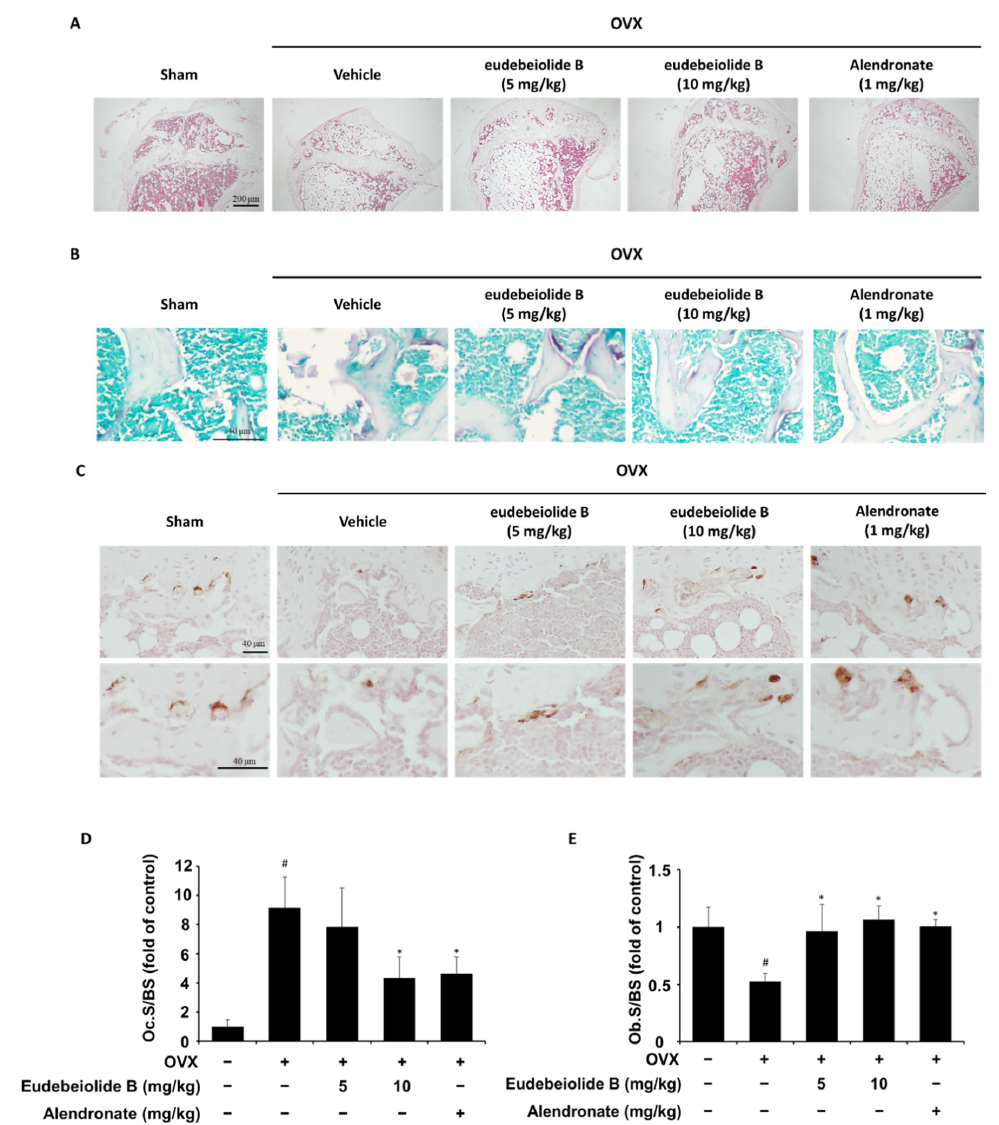
Figure 7. Histological analysis of the proximal tibia tissue sections from the eudebeiolide B- or alendronate-treated OVX mice. ( A ) H&E stains, ( B ) histochemical stains for TRAP and ( C ) immunohistochemical stains for ALP of the sham-operated, OVX + vehicle, OVX + eudebeiolide B-treated and OVX + alendronate-treated mice were obtained ( n = 6). ( D ) Osteoclast surface/bone surface (Oc.S/BS) and ( E ) Osteoblast surface/bone surface (Ob.S/BS) were evaluated by HistoMorph software ( n = 6). Data are expressed as the means ± S.D. # p < 0.05 versus the sham group obtained through the unpaired Student’s t -test; * p < 0.05 versus the only-OVX-treated group obtained through one-way ANOVA followed by Dunnett’s test.